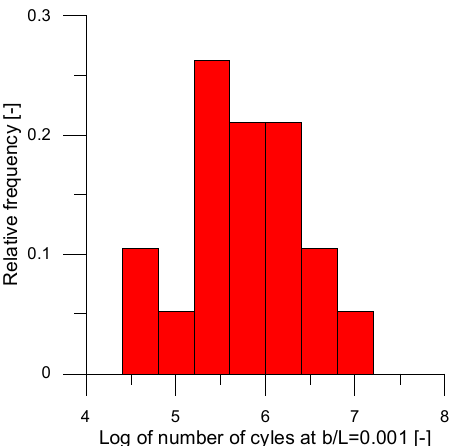
Figure 5: Frequency distribution of the number of cycles (log scale) required to attain a relative bowing b/L of 0.1%, according to the 20 simulations of grain orientations being